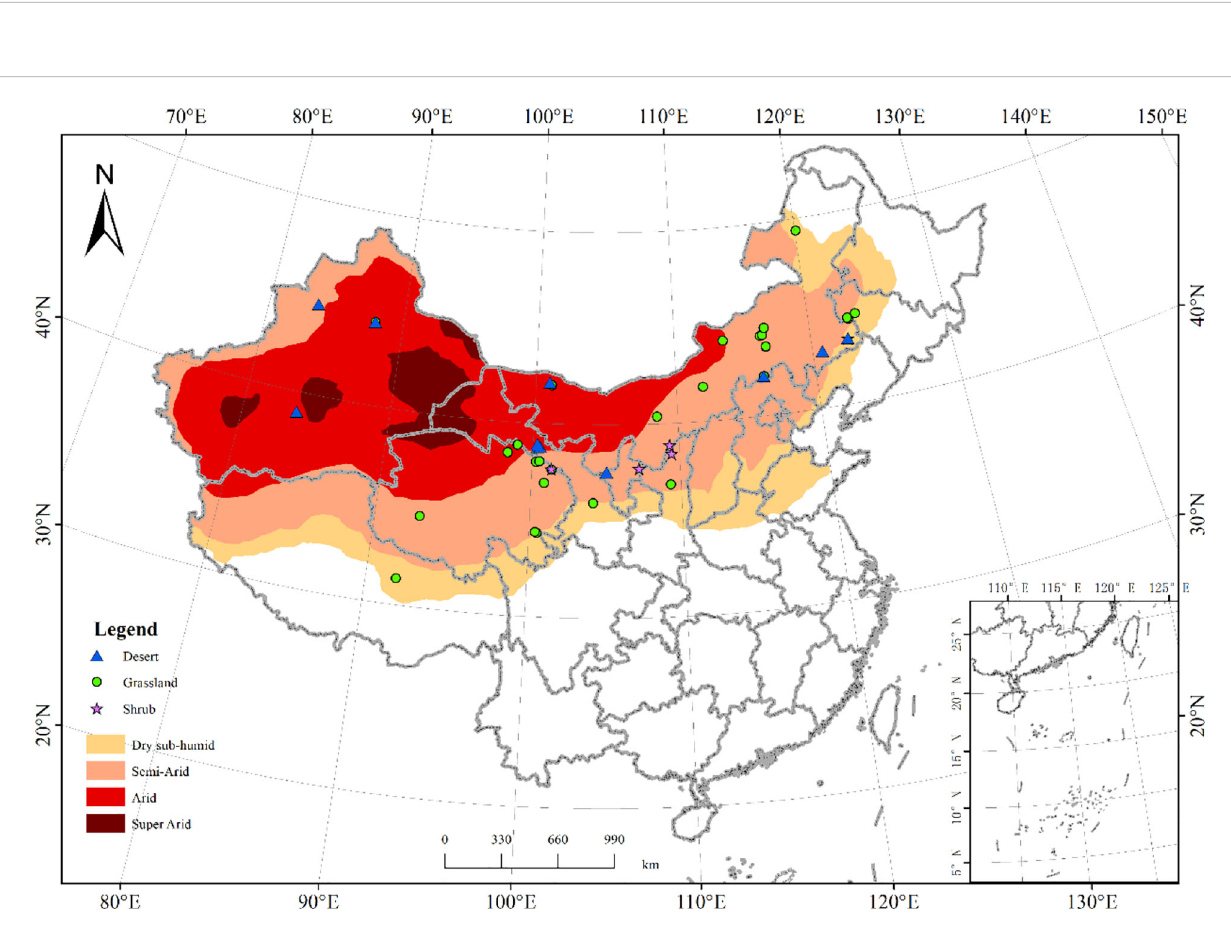
FIGURE 2 The spatial distribution of fl ux sites in Chinese drylands used in this study. The symbols indicate the location of the fl ux sites. The green circles, blue triangles, and purple pentagram symbols indicate the fl ux sites in the grassland (29 sites), shrub (5 sites), and desert regions (11 sites),